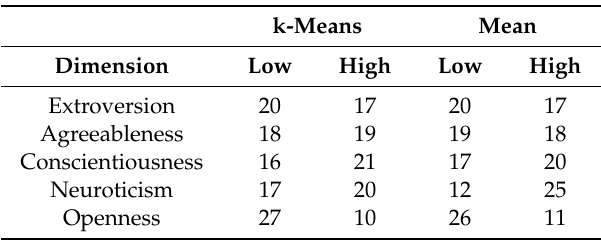
Figure 2. Distributions of the mean scores for each trait. The vertical lines denote the threshold of defining if a score is low or high according to the mean (red) or k-means (black) value of the distribution. In this paper, we used the k-means threshold because it produces groups (low/high) with low differences in respect to size. Table 1. Number of